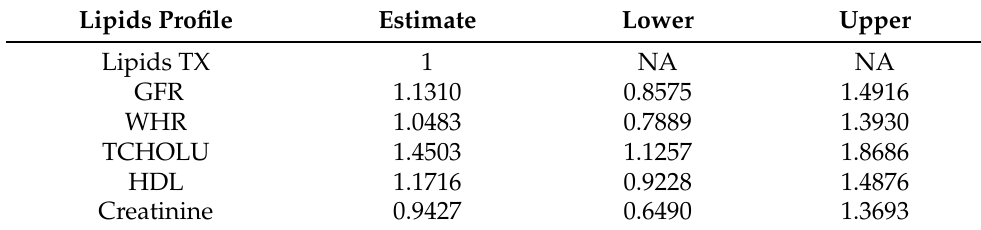
Table 10. Risk Ratio with 95%